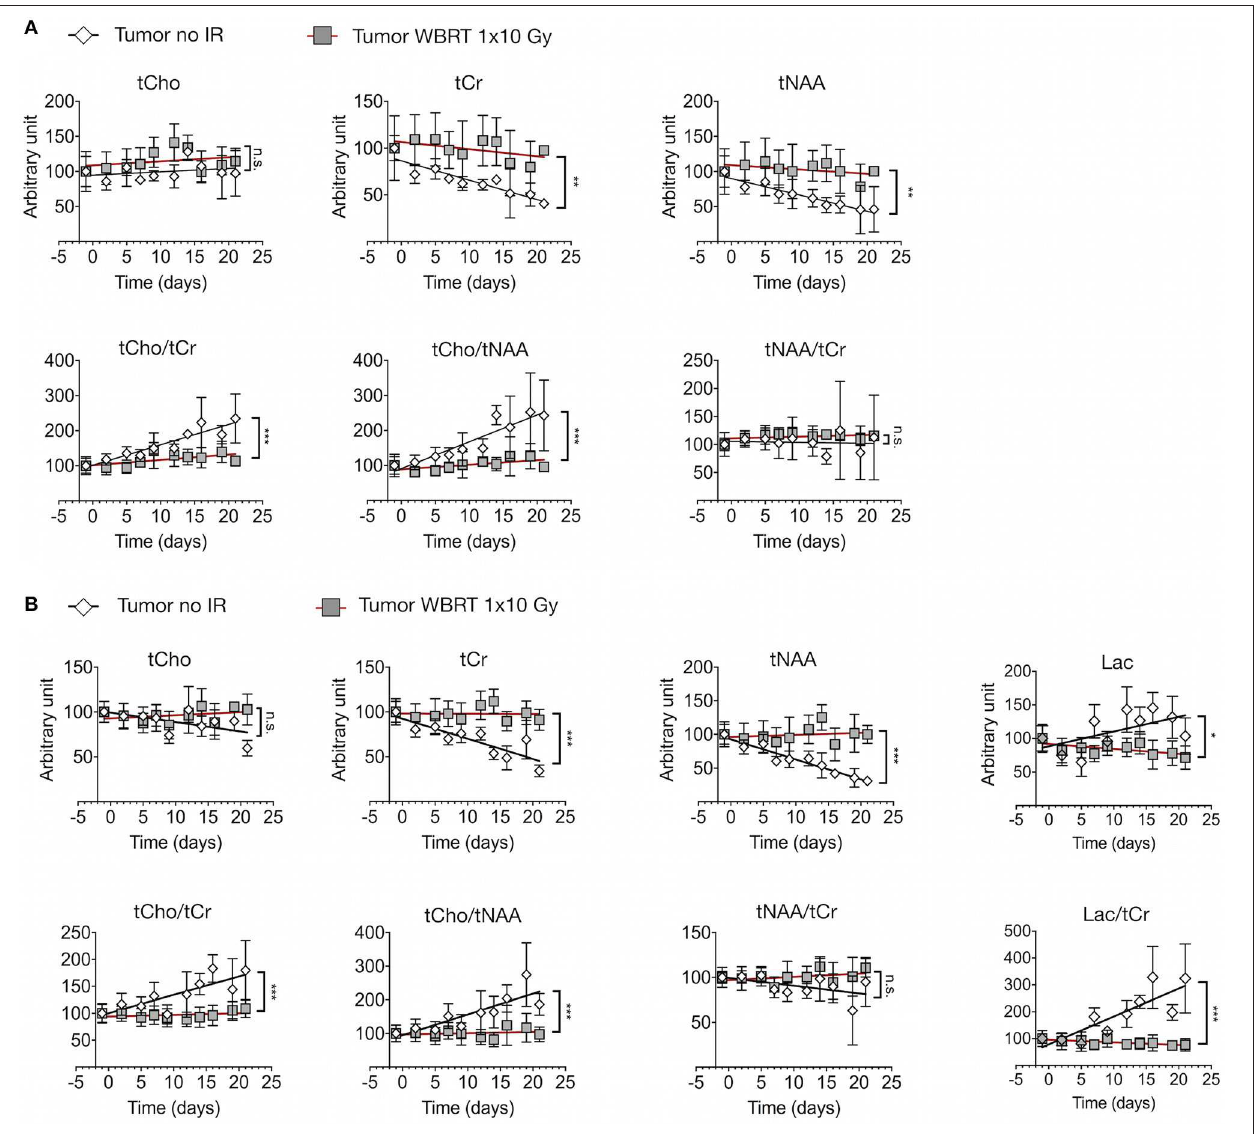
FIGURE 5 | Metabolic changes in response to tumor progression and radiotherapy (A) Signal intensity of tCho, tCr, and tNAA (upper panel) and ratio of tCho/tCr, tCho/tNAA, and tNAA/tCr (lower panel) in tumor-bearing untreated mice ( n = 4) and tumor-bearing mice with WBRT ( n = 3) at short echo time (16.5ms) (depicted as arbitrary units). (B) Signal intensity of tCho, tCr, tNAA and Lac (upper panel) and ratio of tCho/tCr, tCho/tNAA, tNAA/tCr, and Lac/tCr (lower panel) in tumor-bearing untreated mice ( n = 3) and tumor-bearing mice with WBRT ( n = 3) at long echo time (135ms) (depicted as arbitrary units). P -values were calculated based on linear regression analysis and comparison between the slopes. n.s. = not significant, * P < 0.05, ** P < 0.01, *** P <